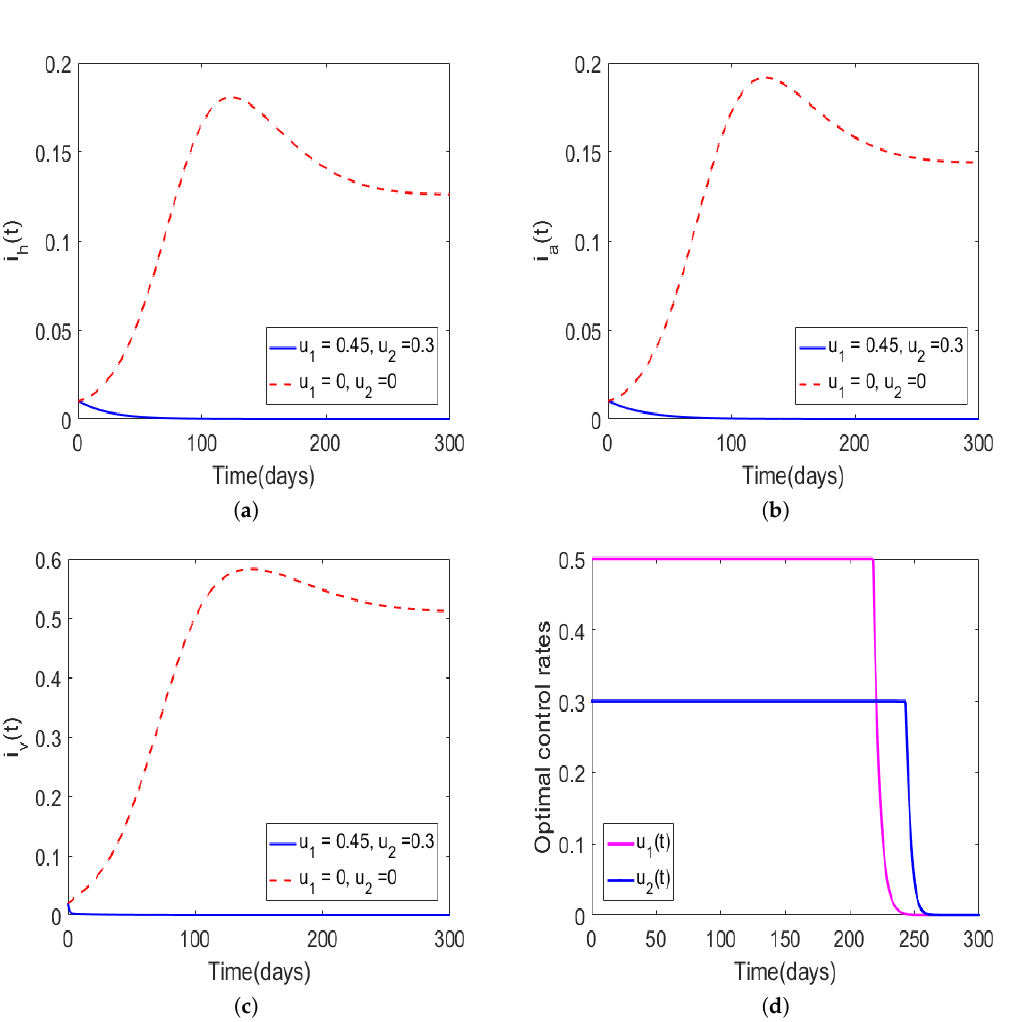
Figure 4. Simulations of model (6) with the initial guesses for the control set to u 1 = 0.45, u 2 = 0.3, and the bounds for the controls set to q 1 = 0.5 and q 2 = 0.3. The rest of the model parameter values were adopted from Table 1. The solid curves in ( a – c ) represent the proportion of infectious humans, infectious animals, and infectious tsetse vectors, respectively, in the presence of time-dependent control and the dotted lines denote the absence of optimal control. The optimal control rates are shown in ( d